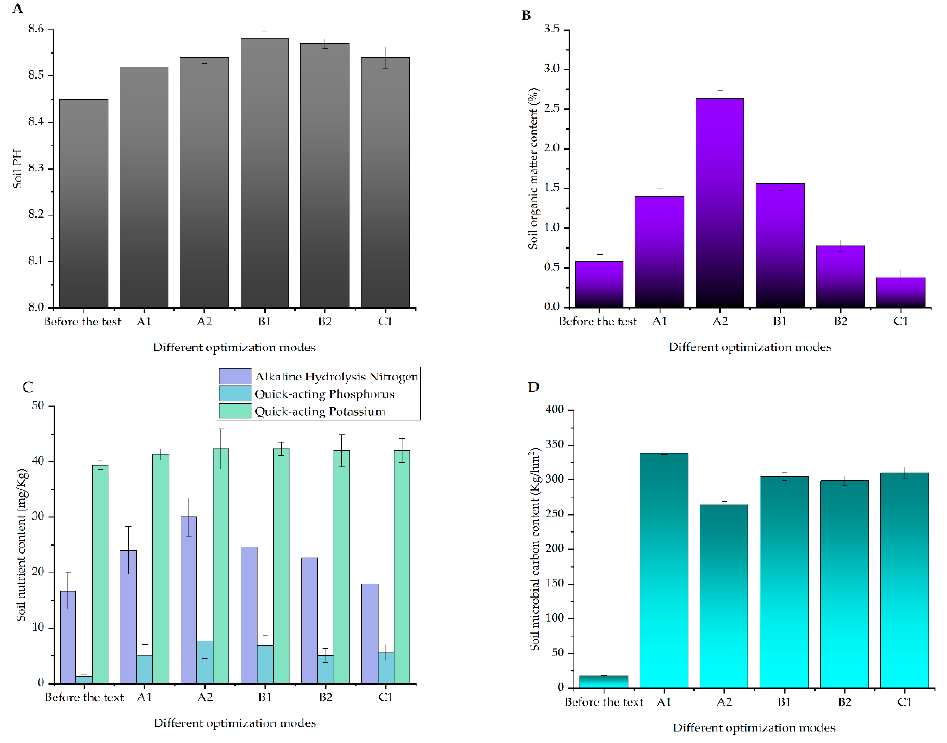
Figure 3. Effects of different optimization models based on woody peat on soil fertility characteristics and MBC. ( A ) Soil pH. ( B ) Soil organic matter content. ( C ) Soil effective nutrient content. ( D ) Soil microbial carbon content.